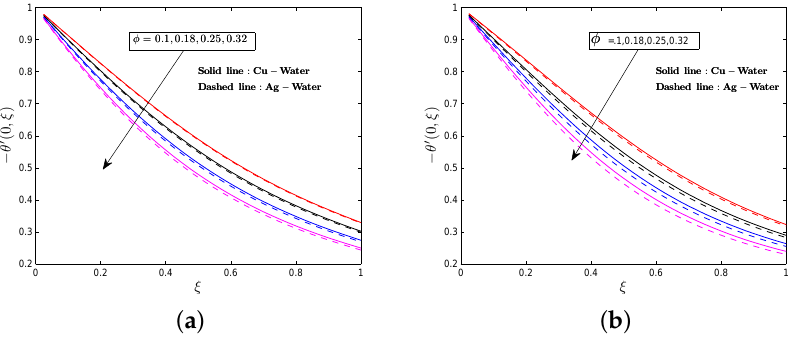
Figure 17. Heat transfer rate for various values of φ . ( a ) vertical plate; ( b ) horizontal plate.